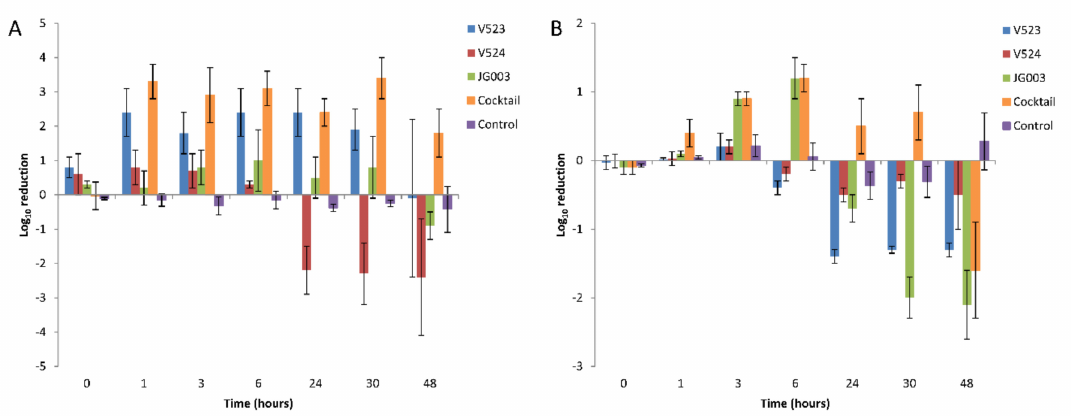
Figure 7. Average log 10 reductions of ( A ) the P. aeruginosa PAO1 strain and ( B ) the environmental strain 17V1507 using bacteriophages in water. Three separate phages and a phage cocktail were tested. Host reductions were determined from triplicate experiments, and the error bars indicate standard